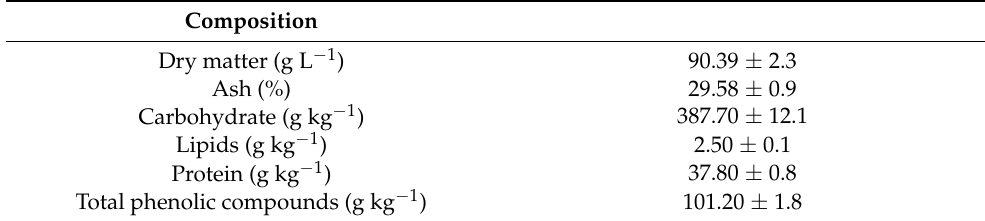
Table 1. Composition of the BSE biostimulant. Each value is expressed based on the total dry matter of the BSE